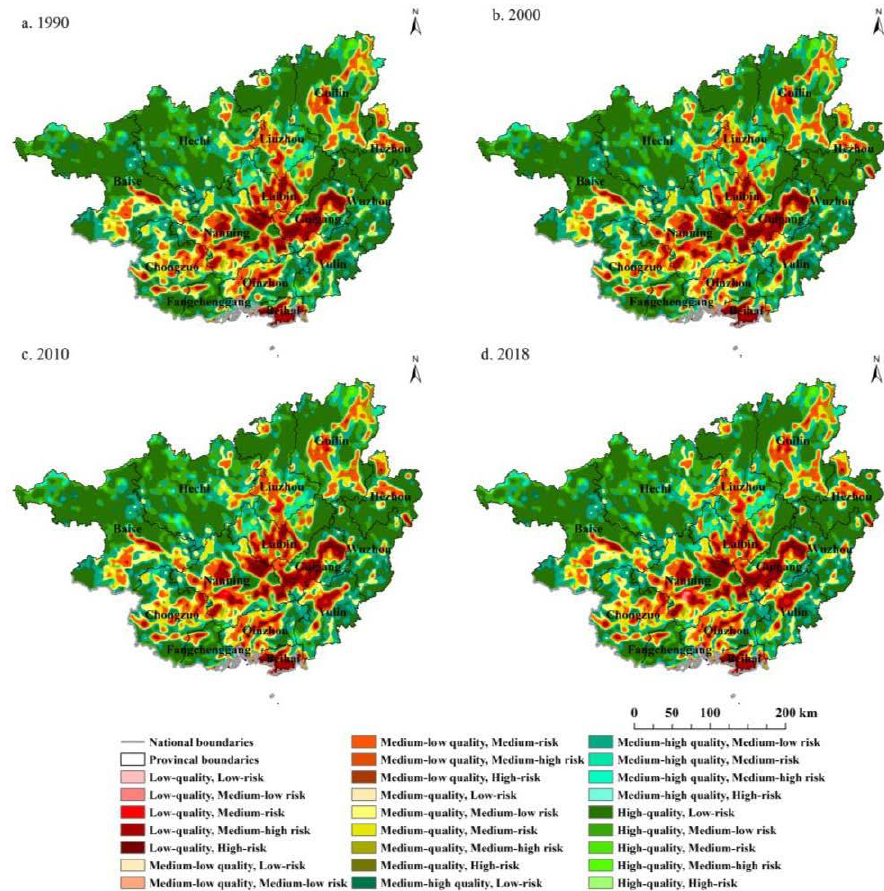
Figure 7. Spatial distributions of comprehensive eco-environmental effects during 1990–2018.